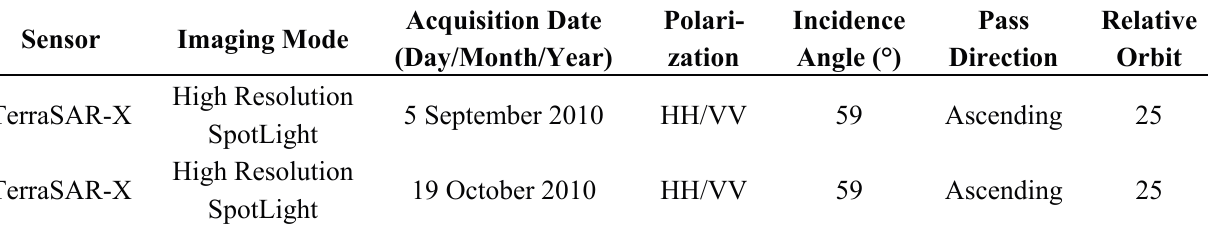
Table 1. Details of used SAR data